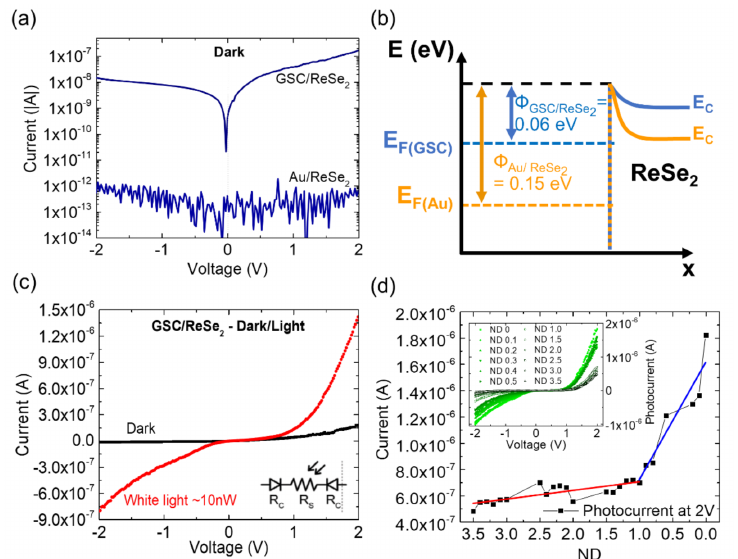
Figure 6. ( a ) I-V curves comparing GSC/ReSe 2 and Au/ReSe 2 devices without light illumination. ( b ) Band diagram of GSC/ReSe 2 and Au/ReSe 2 devices based on the KPFM results. ( c ) Dark and light I-V curves of the GSC/ReSe 2 device and the equivalent circuit with two Schottky barriers connected back-to-back with a series resistance (inset). ( d ) Response of the same device under white light and different attenuator filters (inset) and the corresponding current as a function of attenuator filters to an applied bias of 2 V highlighting the two different linear regimens (red and blue lines) with a transition point at ND~1.